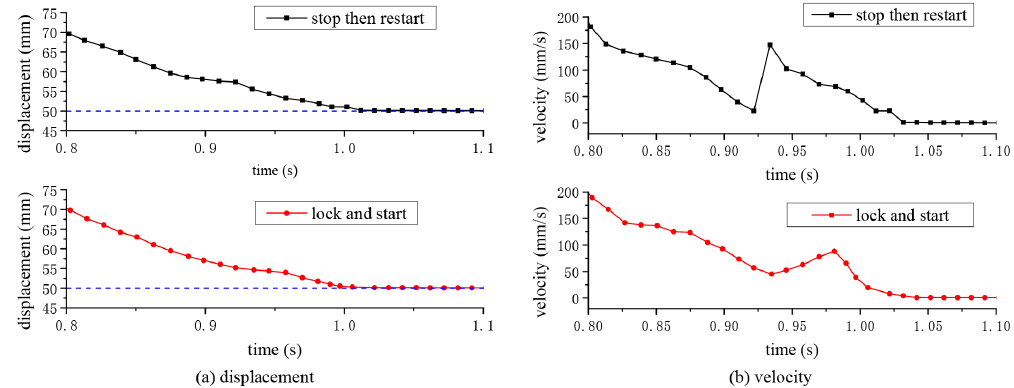
Figure 18. Comparison of the positioning test of 0–450mm with the strategies of lock and start and stop then restart.